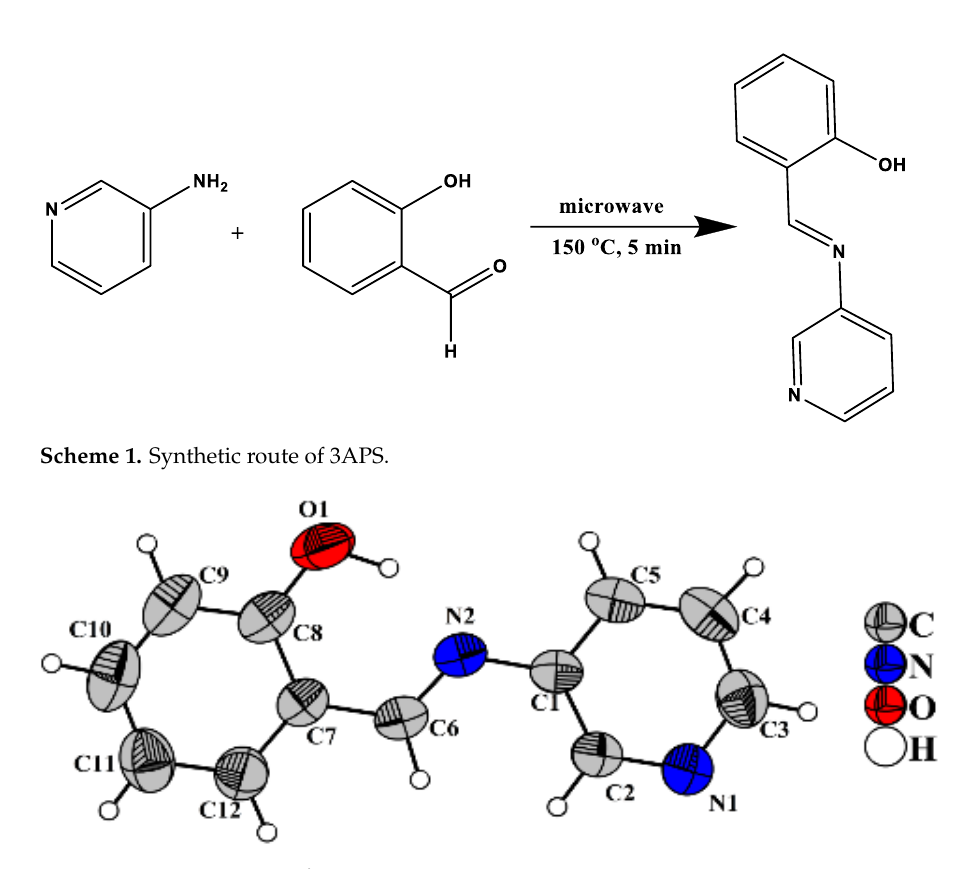
Figure 1. X-ray structure of 3APS.